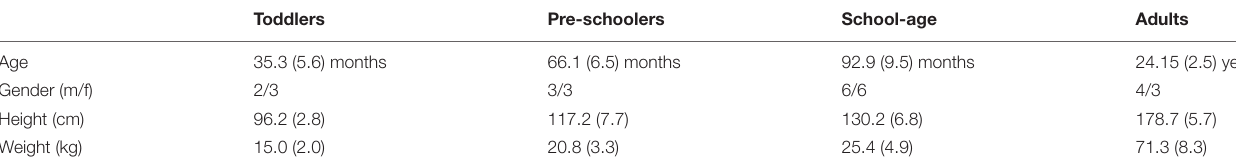
TABLE 1 | Participant characteristics [Mean